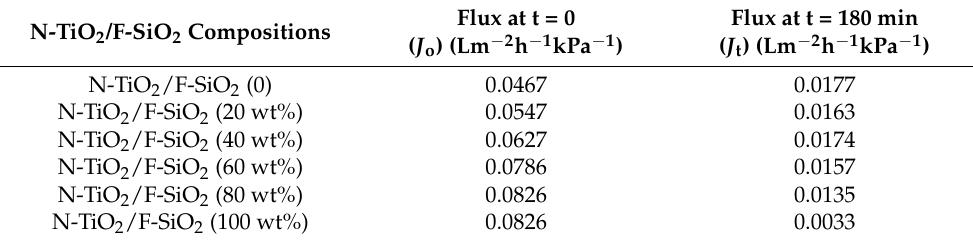
Table 1. The values of the flux of the water-rich permeate through the membranes coated with N- TiO 2 /F-SiO 2 with varied compositions that were subjected to sodium dodecyl sulfate (SDS)-stabilized n-hexadecane-in-water emulsion (10:90 vol:vol, n-hexadecane:water) dissolved with salt (1.0 wt% NaCl with respect to the water